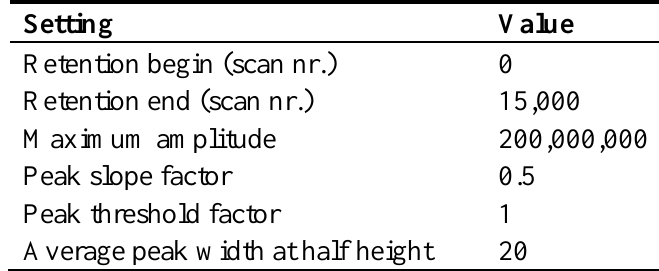
Table 1. MetAlign settings used to automatically process the experimental